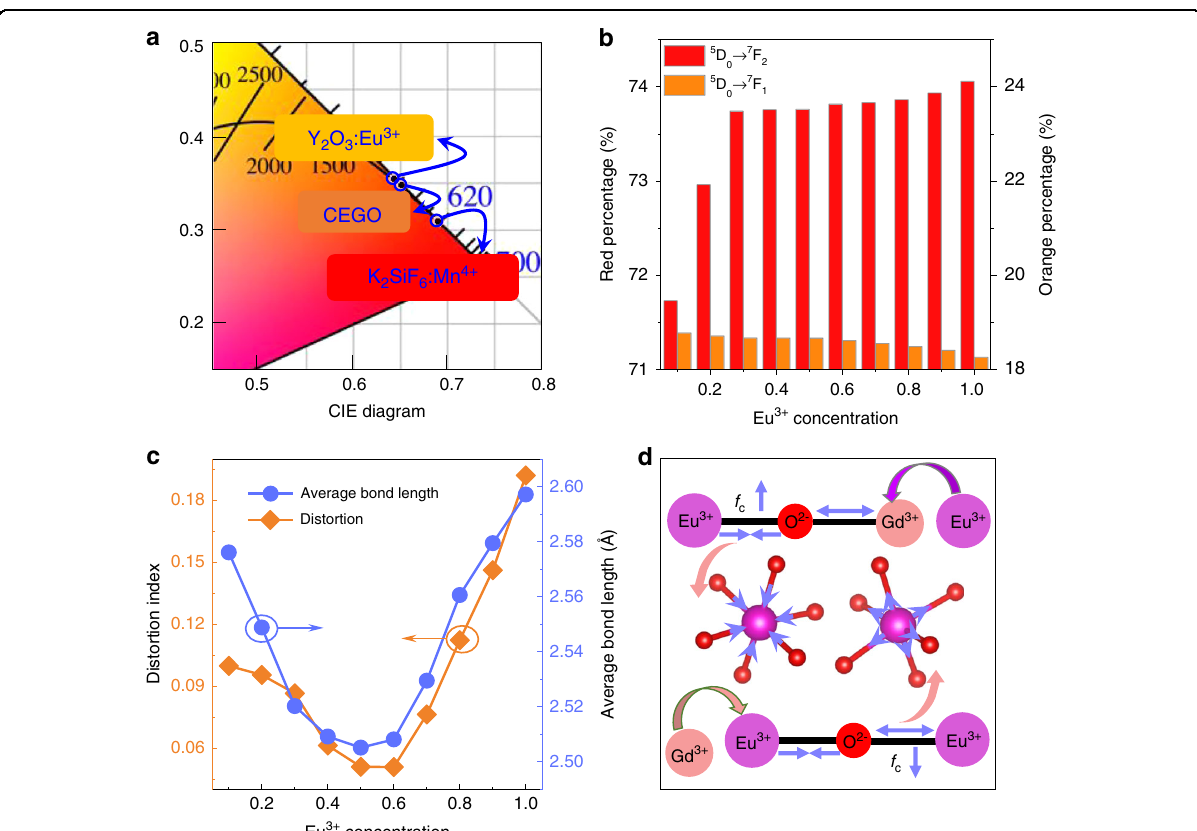
Fig. 3 Red-to-orange ratio and symmetry. a CIE chromaticity coordinate diagram of CEGO compared with the commercial red Y 2 O 3 :Eu 3 + and K 2 SiF 6 :Mn 4 + phosphors. b The variation trend of the 5 D 0 – 7 F 2 (red) and 5 D 0 – 7 F 1 (orange) transitions in the PL spectra for the CGGO: x Eu 3 + ( x = 0.1 – 1.0) samples. c Variation in the distortion of the EuO 6 octahedron and average bond length of Gd/Eu – O with increasing Eu 3 + concentration in the CGGO: x Eu 3 + ( x = 0.1 – 1.0) samples. d Schematic diagram of the variation in the covalence degree and length of Eu – O bonds in the Eu 3 + -doped